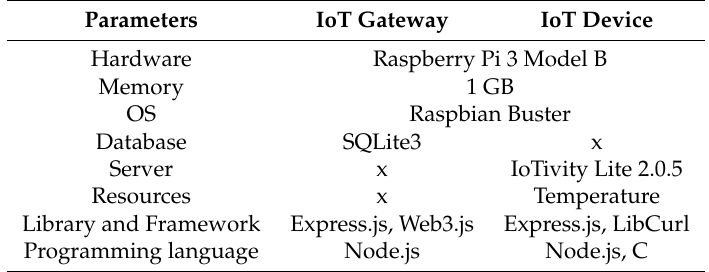
Table 3. Development environment for the IoT gateway and the IoT